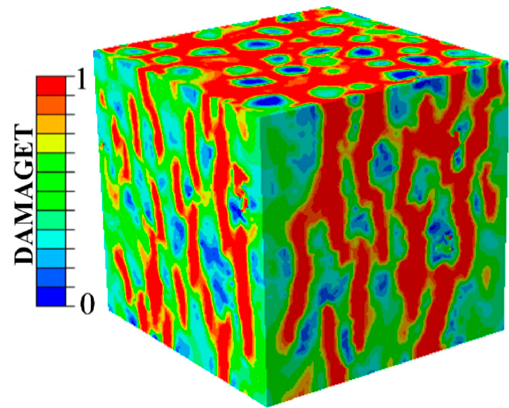
Figure 14. Damage pattern when σ 1 (X)/ σ 3 (Y) = 1.